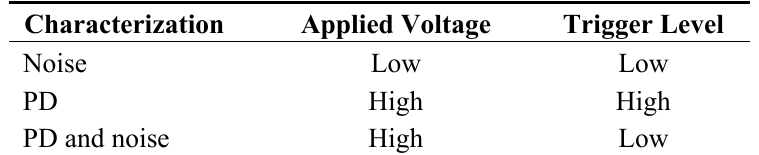
Table 1. Trigger and voltage levels to characterize noise, PD and PD +